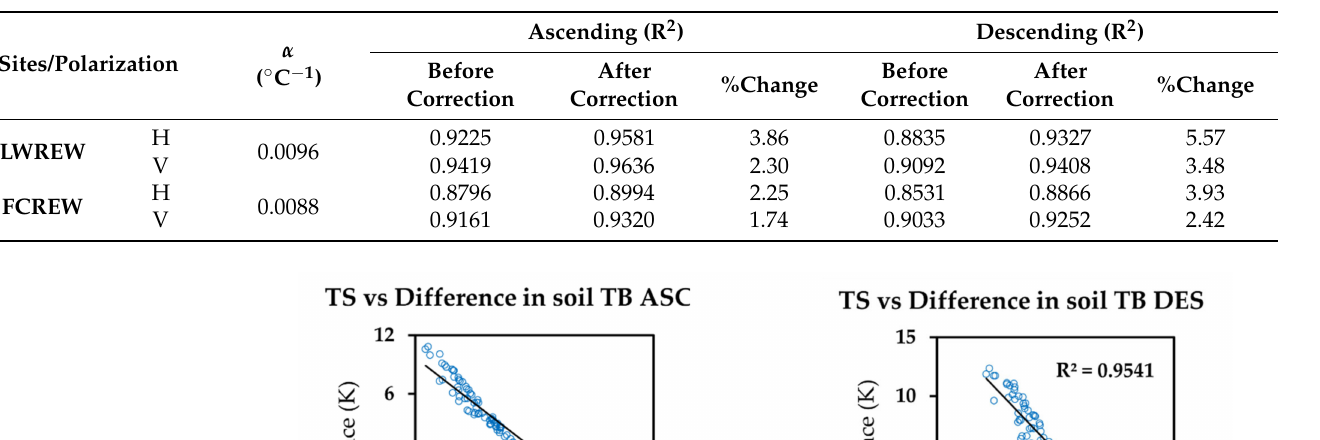
Table 4. The changes in the coefficients of determination of the regression between soil TB and SMAP TB of all polarizations at the ascending and descending nodes, at all sites.